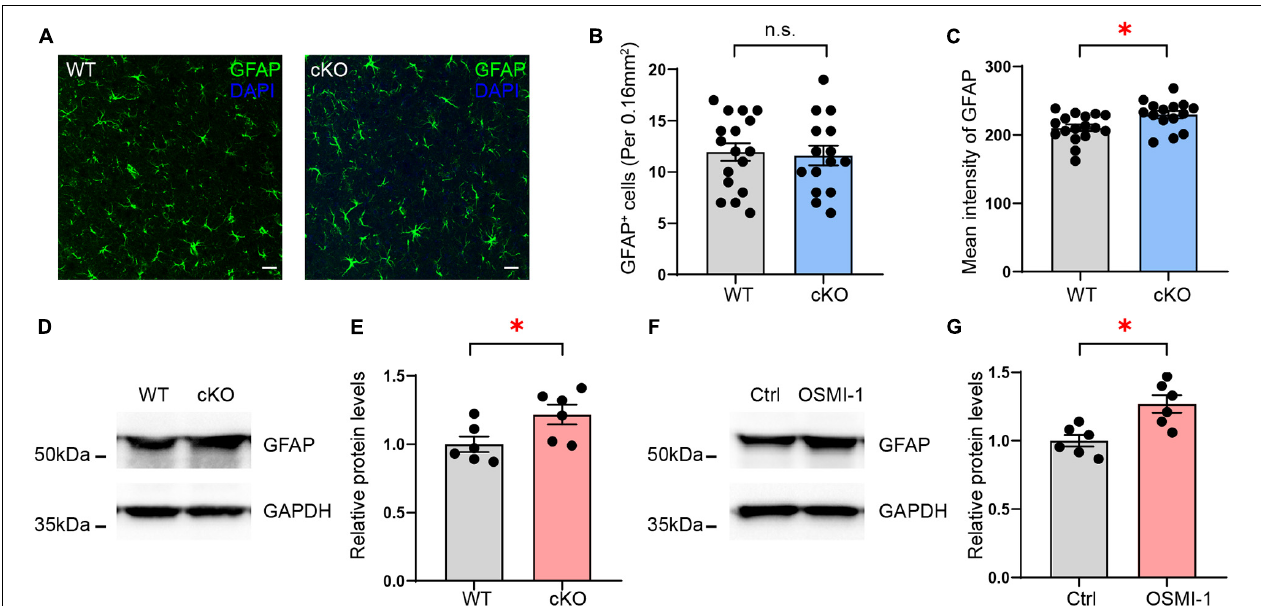
FIGURE 9 | Validation of GFAP expression regulated by OGT in astrocytes. (A) Immunofluorescence staining of GFAP (green) in astrocyte-specific OGT conditional knockout mice and WT mice. Scale bar = 20 µ m. (B) Quantification of GFAP positive cells in the mPFC of cKO and WT mice. n = 17 (WT), 15 (cKO). (C) Quantification of mean fluorescence intensity in the mPFC of cKO and WT mice. n = 17 (WT), 15 (cKO). (D,E) Western blot images (D) and quantification (E) of GFAP expression in the mPFC of astrocyte-specific OGT conditional knockout mice and controls. The blots were cropped according to their molecular weight. Tissue levels of GAPDH were used as loading controls. Protein expression was normalized to the control levels. n = 6 (WT), 6 (cKO). (F,G) Western blot images (F) and quantification (G) of GFAP levels in primary cultured astrocytes treated with OGT inhibitor (OSMI-1) and controls. n = 6 (Control), 6 (OSMI-1). Two-sided unpaired t -test. ∗ P < 0.05; n.s: no